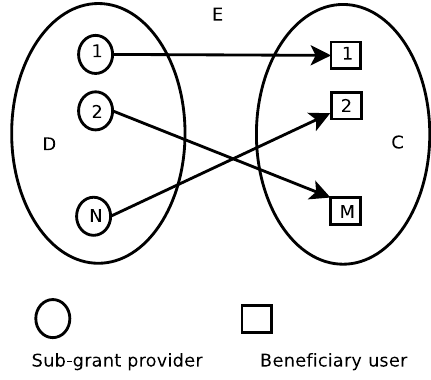
Fig. 5 An illustrative example of graph